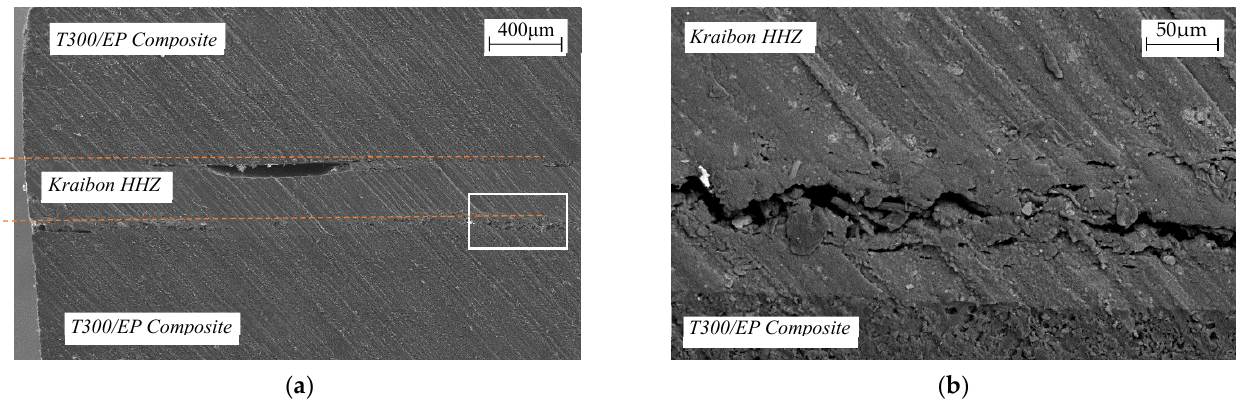
Figure 8. SEM images of a sandwich damped with Kraibon HHZ: magnitude ( a ) 110× and ( b ) 1000×.